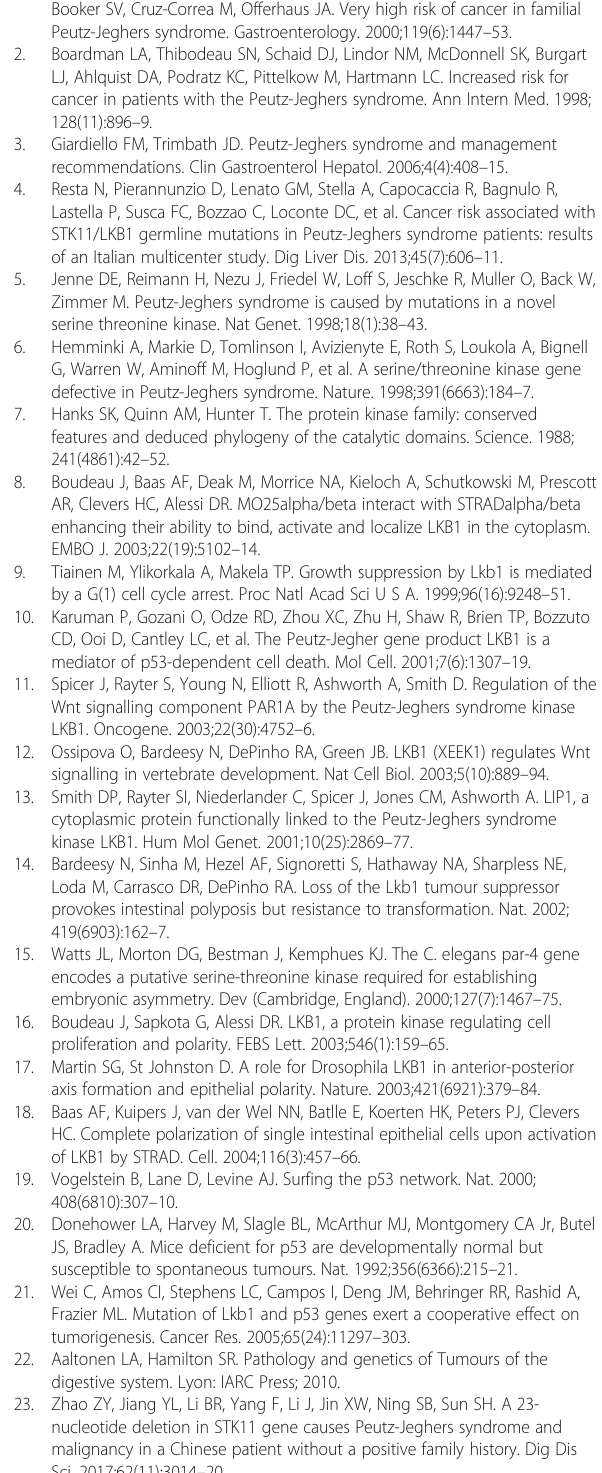
Additional file 1: Table S1 . Primers for exon-specific sequencing of STK11 gene. Table S2 . Native place of PJS patients. Table S3 . Association between cancer history and certain factors in the cohort of PJS. (DOCX 24 kb) Additional file 2: Figure S1 . Flow diagram of patients enrollment. PJS indicates Peutz-Jeghers syndrome. Figue S2 . The predicted protein struc- ture of 8 truncating mutations (A) and the PolyPhen-2 prediction results for 5 missense mutations (B). NLS, nuclear location signal. Figure S3 . Western blot results of the mutation investigated. Targeted protein: STK11; internal reference: GAPDH. (ZIP 2634